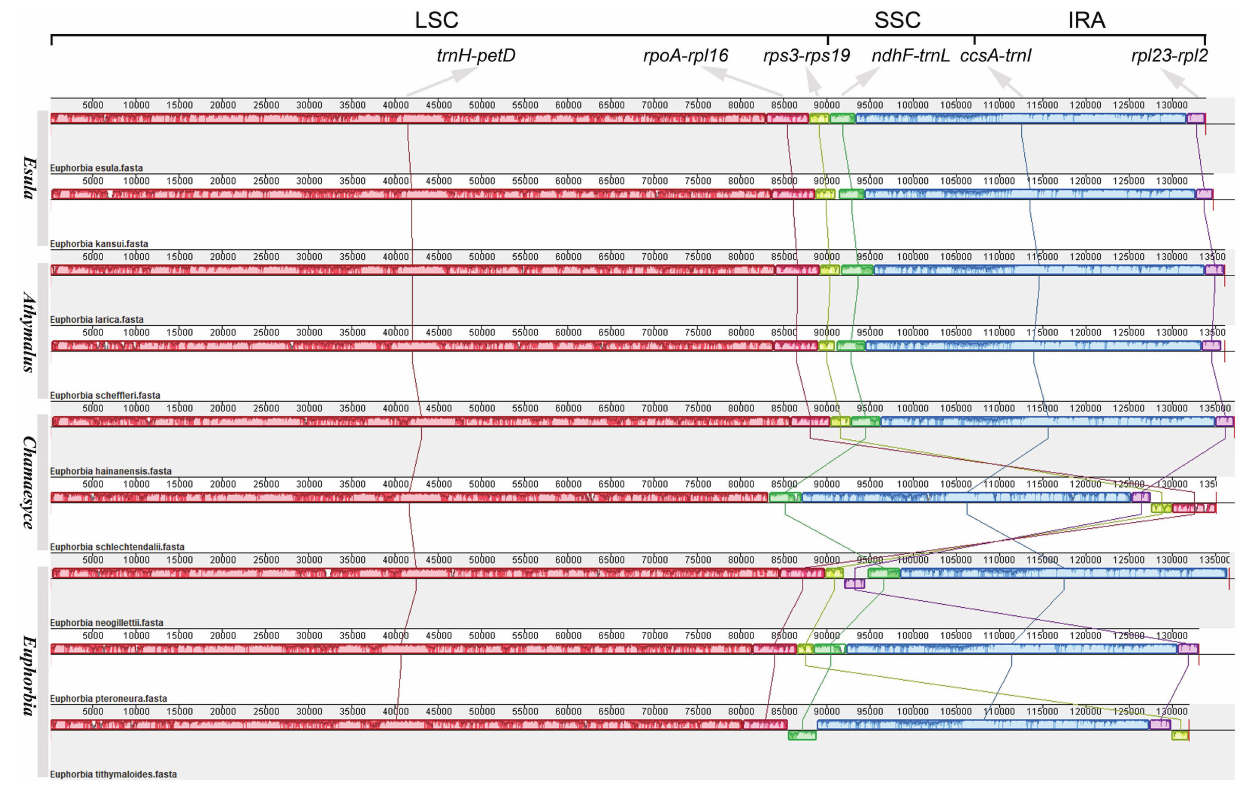
FIGURE 2 | Structural alignment of Euphorbia plastomes representing the four subgenera Esula , Athymalus , Chamaesyce , and Euphorbia . The inverted repeat region B (IRB) was removed from the analysis (see Methods ). Six colored blocks represent locally collinear blocks (LCBs), and the blocks connected by lines indicate homology. The terminal genes of each LCB are marked at the top. Blocks below the horizontal line indicate inversions relative to the reference ( E. esula ). The height of the colored region within a block reflects the average sequence identity relative to the reference. Numbers on the upper x -axis are genome map coordinates in kilobases (Kb). Vertical lines after species names, from top to bottom, indicate each